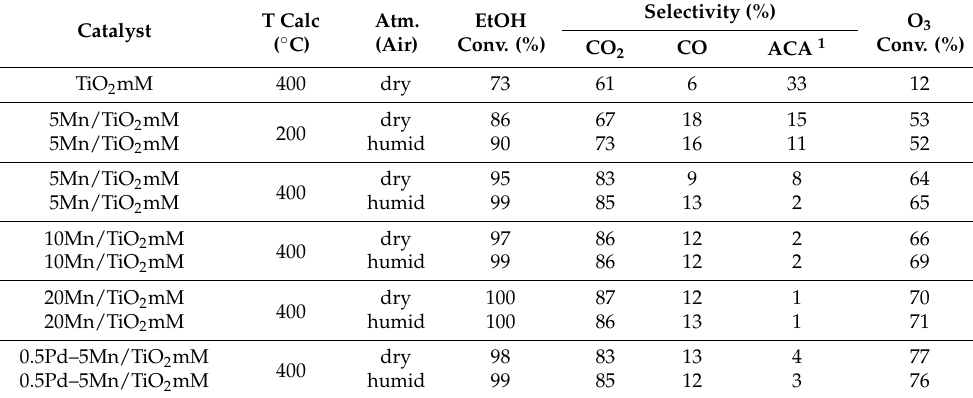
Table 3. Ethanol oxidation on the TiO 2 mM, 5Mn/TiO 2 mM and 0.5Pd–5Mn/TiO 2 mM catalysts in powdered form, in dry and humid air (10%RH) conditions (catalyst = 20 mg, total